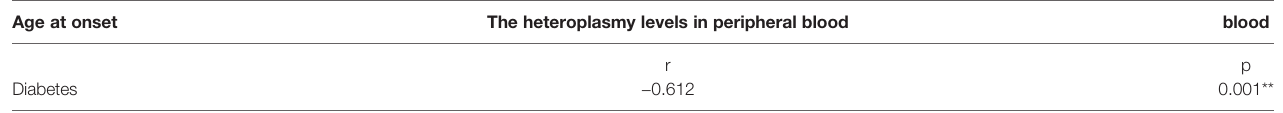
TABLE 2 | Correlation between blood heteroplasmy levels of the m.3243A>G mutation and age at the onset of diabetes. Age at onset The heteroplasmy levels in peripheral blood blood r p Diabetes − 0.612 0.001** **p <